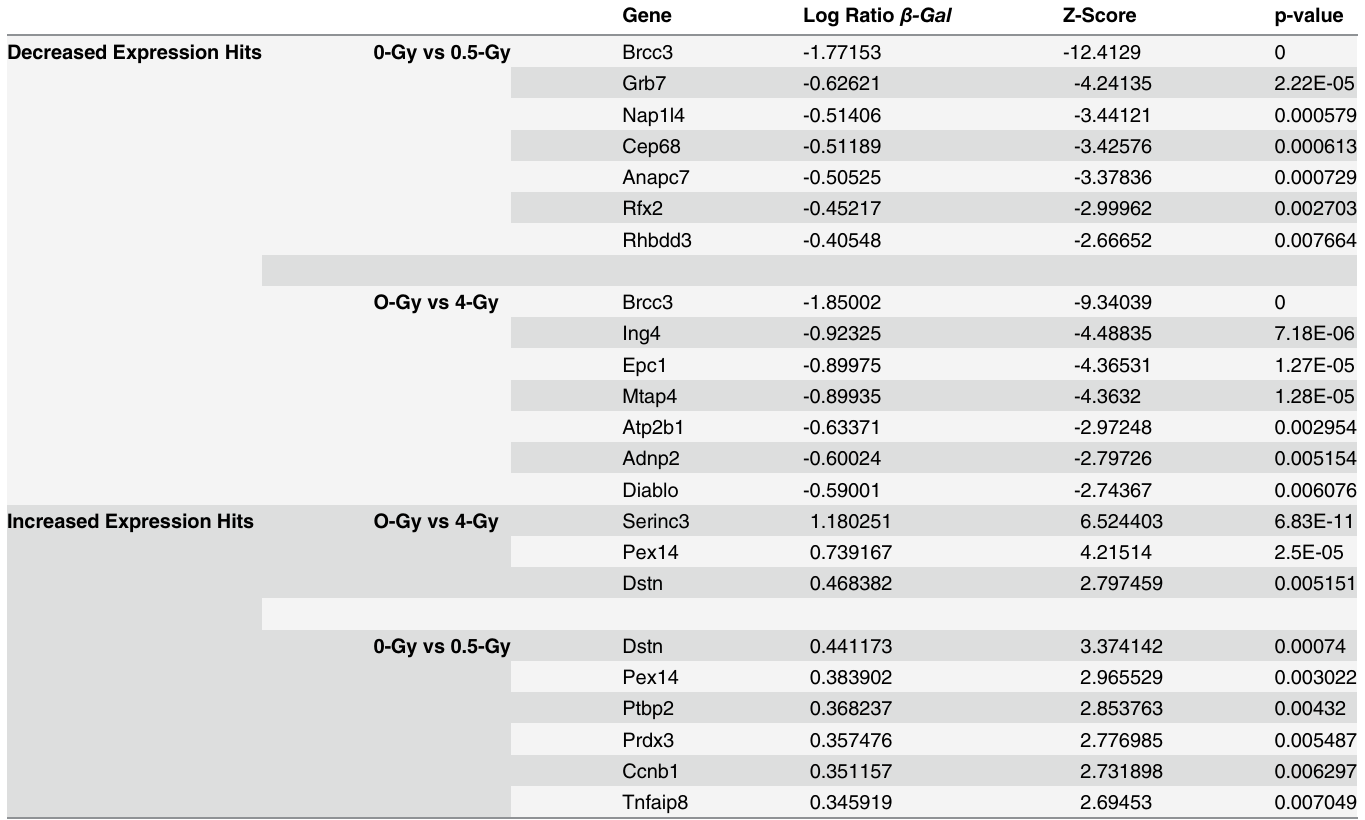
Table 2. Genes associated with significant changes in gene